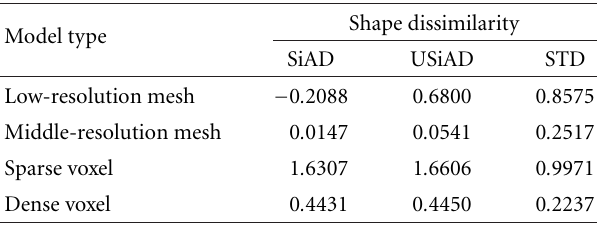
Table 2: Measured shape dissimilarity. (SiAD: Signed average dis- tance, USiAD: Unsigned average distance, STD: Standard devia-